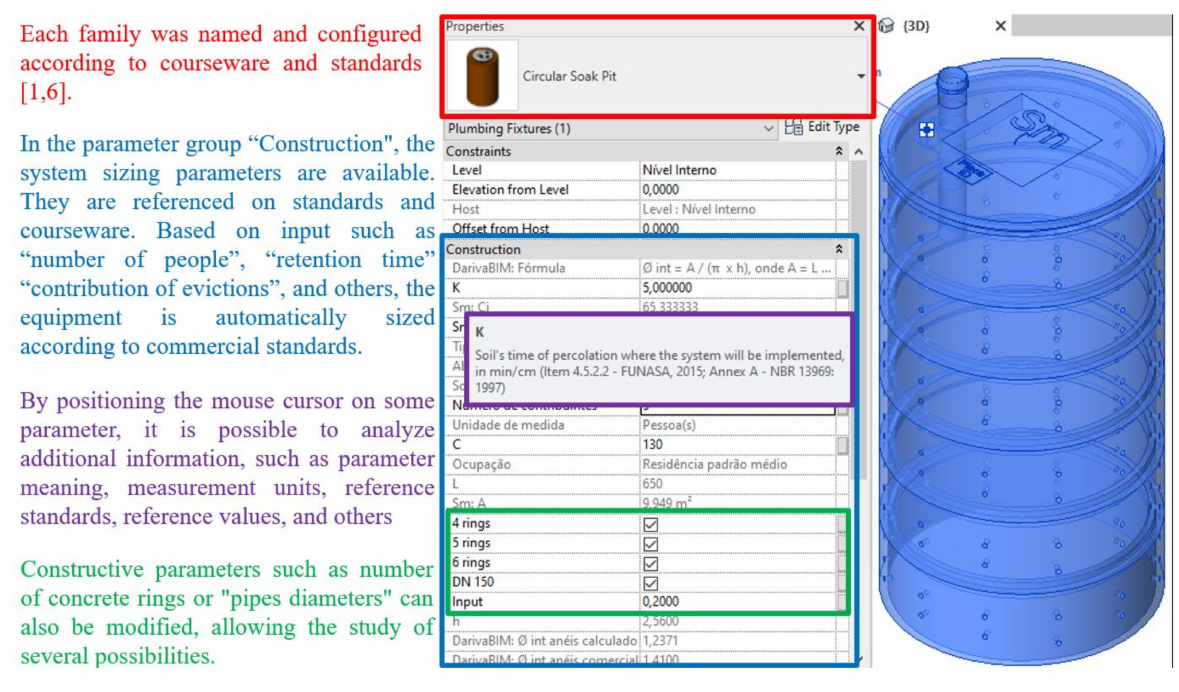
Figure 2. Some information about how the component parameters work. Source: authors (2021).